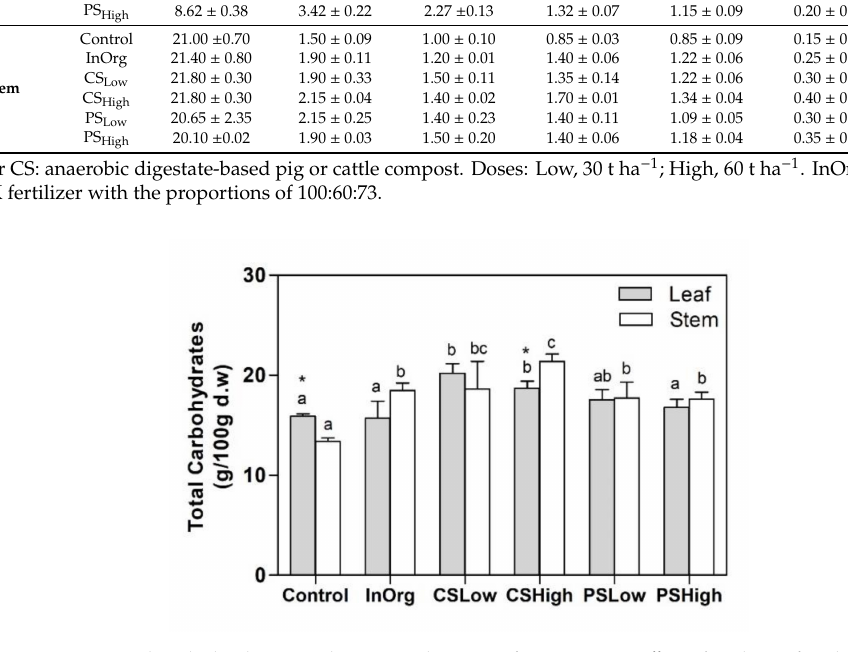
Figure 6. Structural carbohydrates in leaves and stems of Rosmarinus o ffi cinalis plants for the fertilizing treatments: Control, InOrg, CSLow, CSHigh, PSLow and PSHigh. Vertical bars indicate standard errors of the means ( n = 3). Di ff erent lowercase letters indicate significant di ff erences among fertilization treatments ( p < 0.05). Asterisks indicate significant di ff erences among plant parts ( p < 0.05).